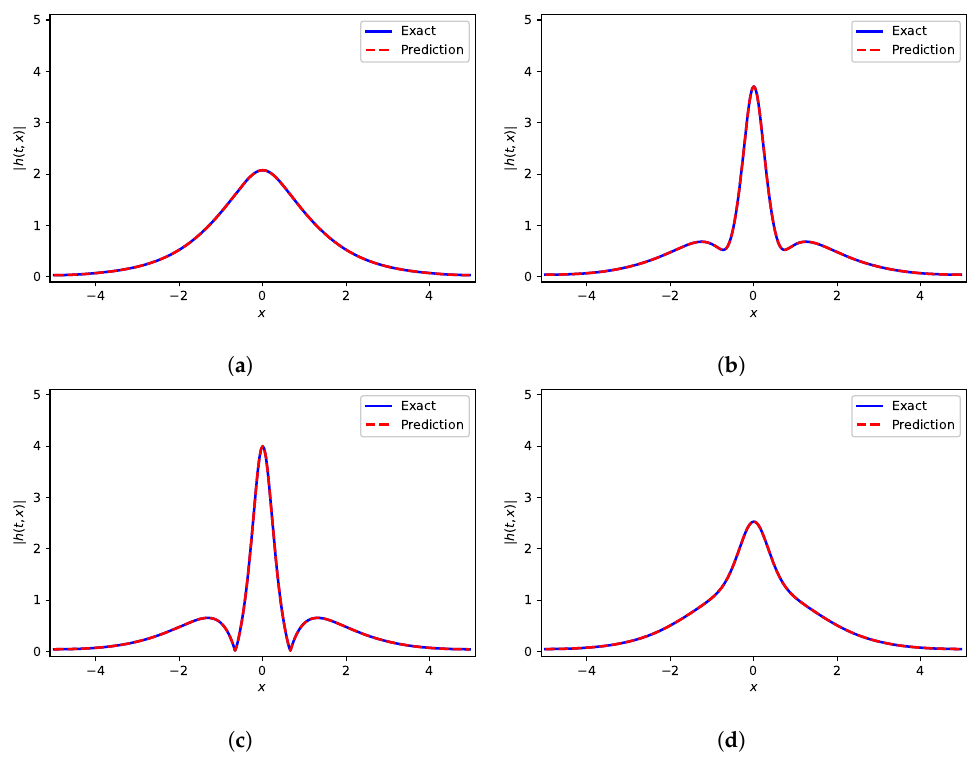
Figure 6. Comparison of predicted solution and exact solution of Equation (22) corresponding to